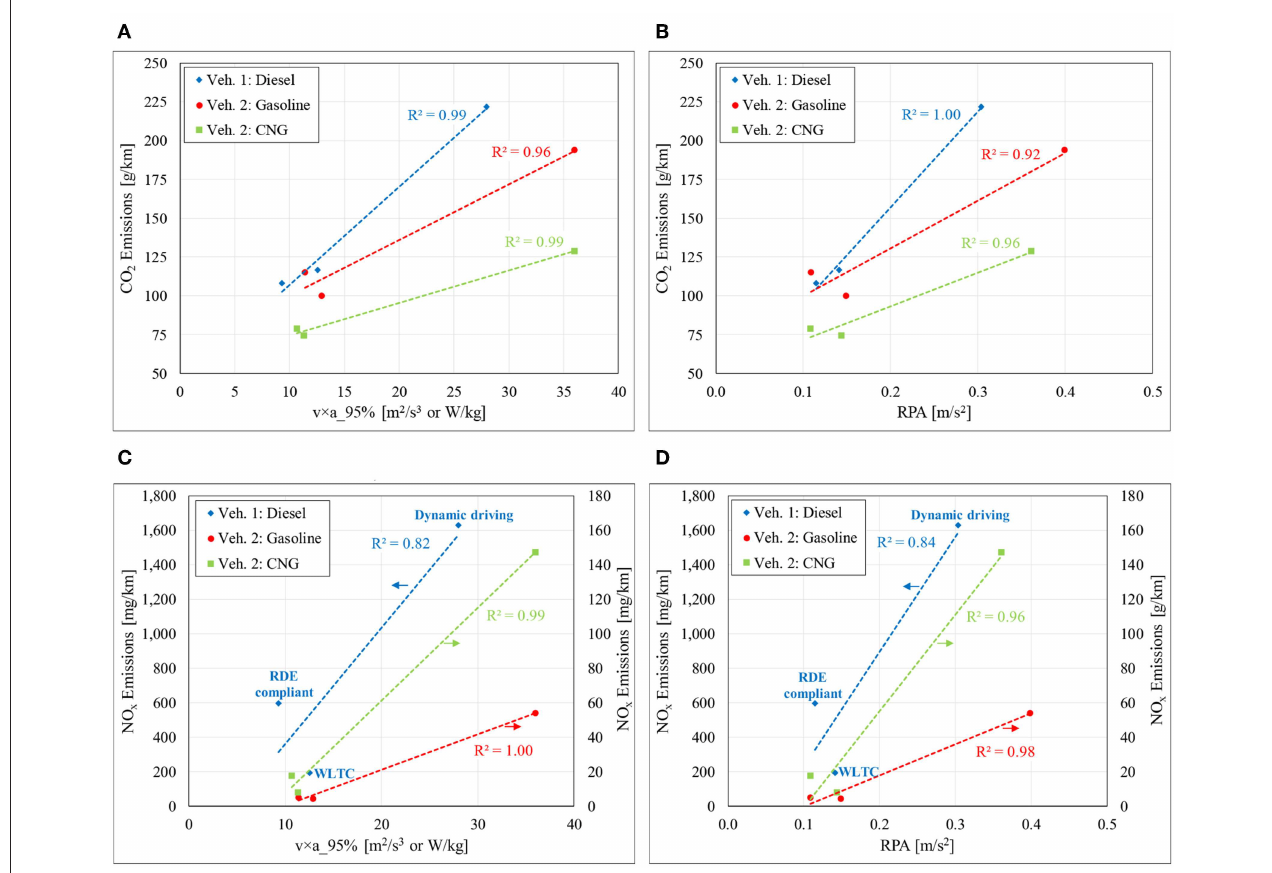
FIGURE 7 | Correlation of CO 2 (A,B) and NO x (C,D) emissions with driving